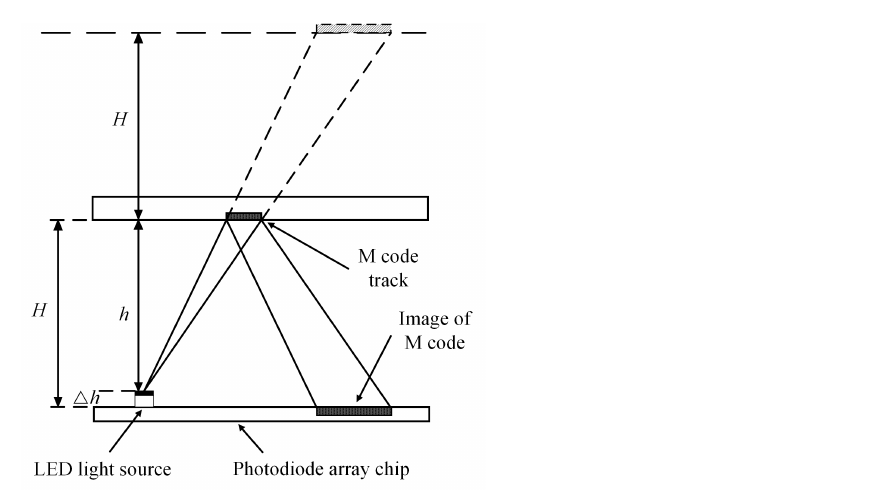
Figure 4. Schematic diagram of code track pattern amplification relationship.